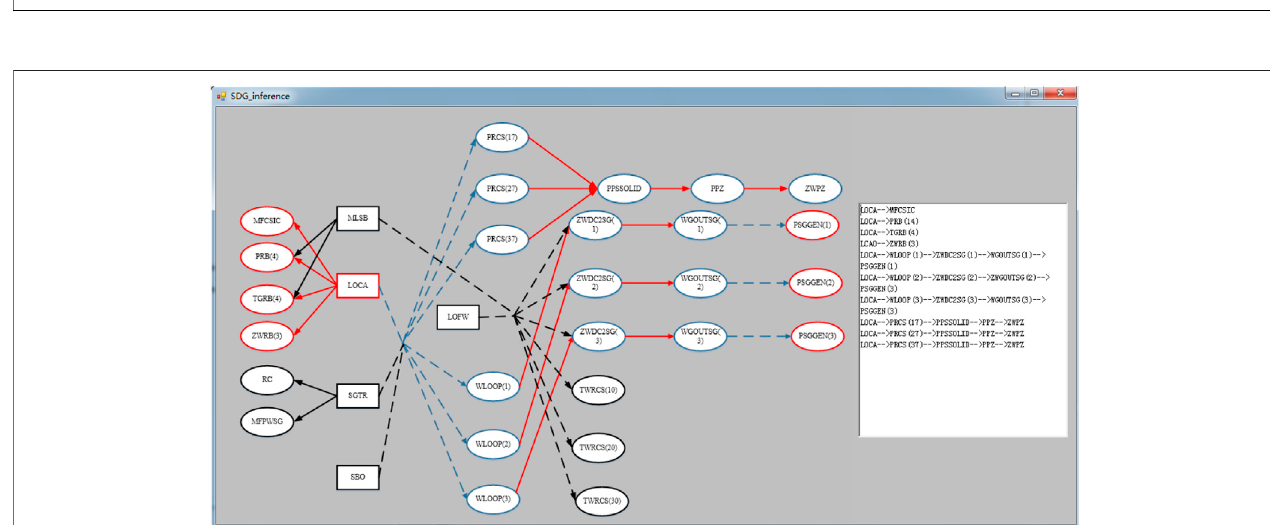
FIGURE 12 | Process monitoring on TGRB (4) when LOCA occurred.